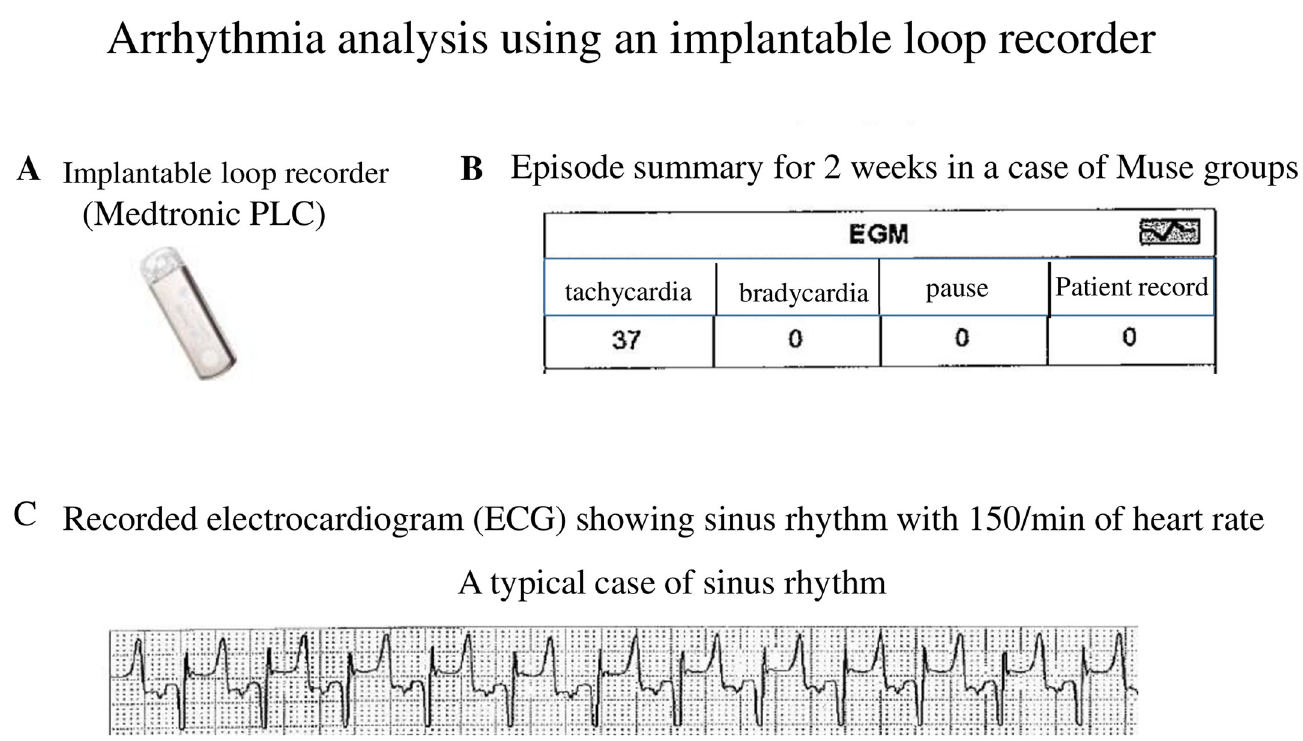
Fig 4. Analysis of arrythmias using an implantable loop recorder. A: Implantable loop recorder. B, C: Episode summary for 2 weeks in a case of Muse groups, showing no arrythmias such as bradycardia, pause except for tachycardia. we see the recorded electrocardiogram as shown in C, this was judged as a 300/min of tachycardia in the loop recorder. However, careful analysis of electrocardiogram revealed that the recorder judged T wave and R wave as a one beat and then the heart rate was regarded as a 300/min of tachycardia, but it was actually a 150/min of heart rate. Therefore, this was not a real tachycardia of 300/min.